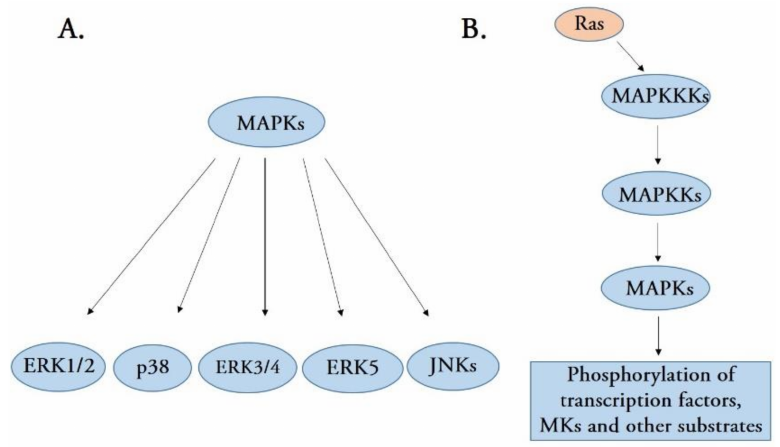
Figure 1. ( A ) A schematic representation of the five distinct groups of mitogen-activated protein kinases (MAPKs), including extracellular signal-regulated kinases 1 and 2 (ERK1/2), p38, ERK3/4, ERK5, and c-Jun N-terminal kinases (JNKs). ( B ) Stress-activated MAPK signaling pathways. MAPK signaling pathways are structurally organized as a signaling cascade, leading to the phosphorylation of many transcription